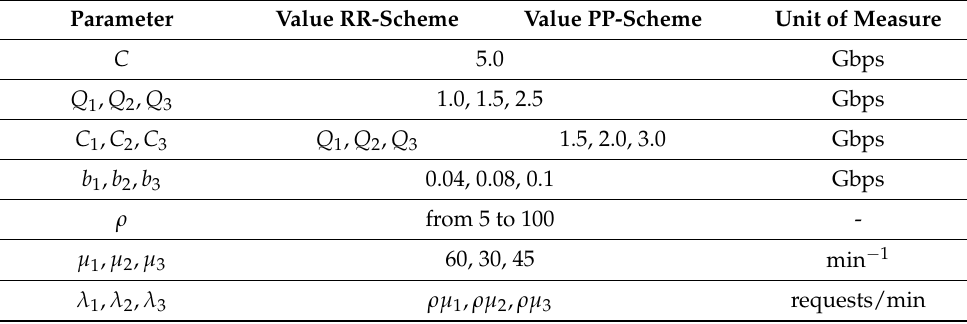
Table 2. Input parameters of comparative analysis [41].